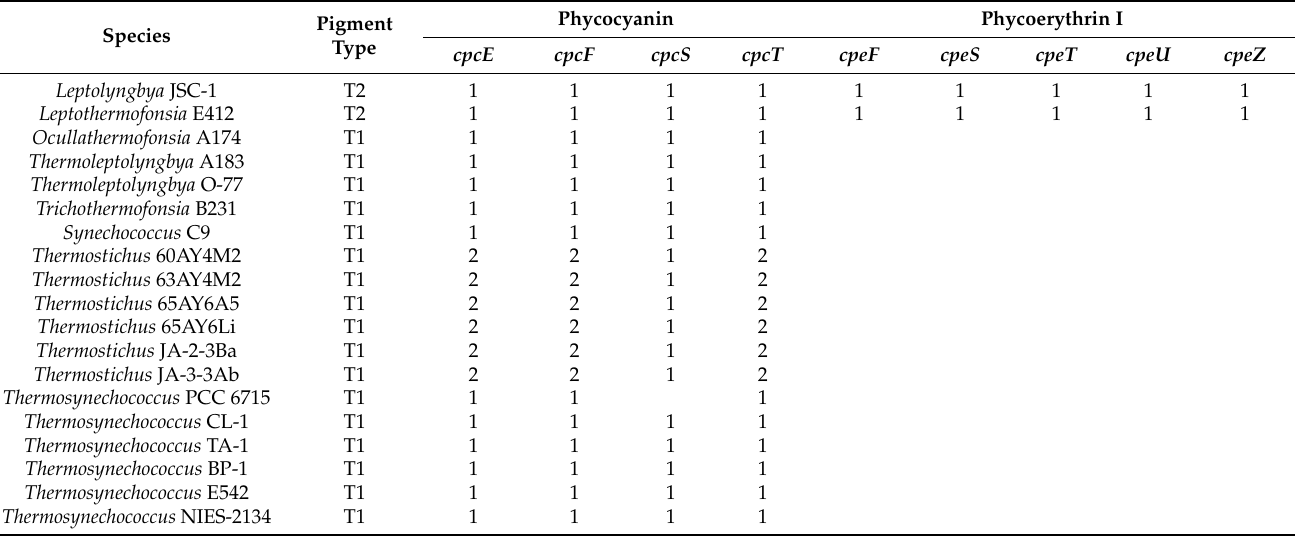
Table 4. Availability of genes encoding putative phycobilin lyases in the genomes of thermophilic cyanobacteria